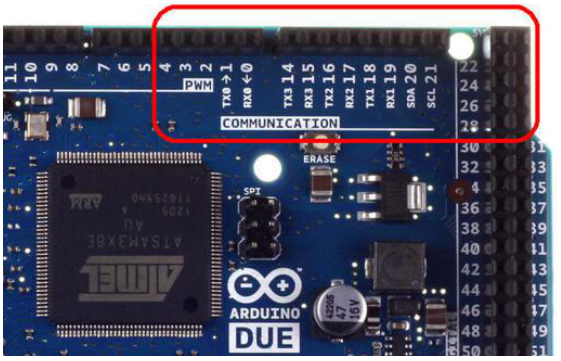
Figure 34. Arduino DUE communication pins with multiple typed pairs.